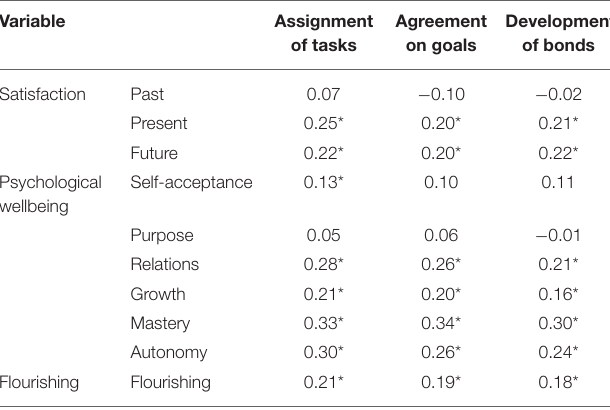
TABLE 3 | Spearman’s rho correlation coefficients between the dimensions of alliance and the dimensions of wellbeing, life satisfaction, and flourishing. Variable Assignment